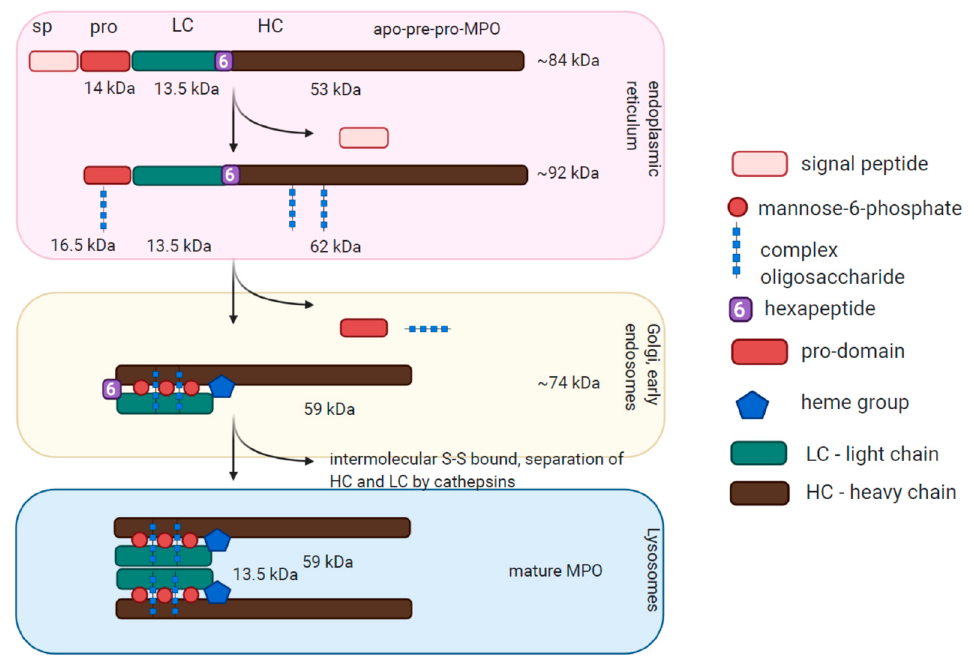
Figure 1. Structure and maturation of Myeloperoxidase. Myeloperoxidase (MPO) is translated as an 84 kDa apo-pre-pro- MPO protein and undergoes several maturation steps. The first step of maturation takes place in the endoplasmic reticulum, where proteins acquire post-translational modifications and lose the signal peptide. The second step occurs in the Golgi apparatus and early endosomes, where the heme group is acquired and the pro-domain is lost. The third step takes place in lysosomes, where the intermolecular S–S bounds are formed and heavy and light chains of MPO are separated with the formation of mature MPO. Adapted from Laura et al. [10].